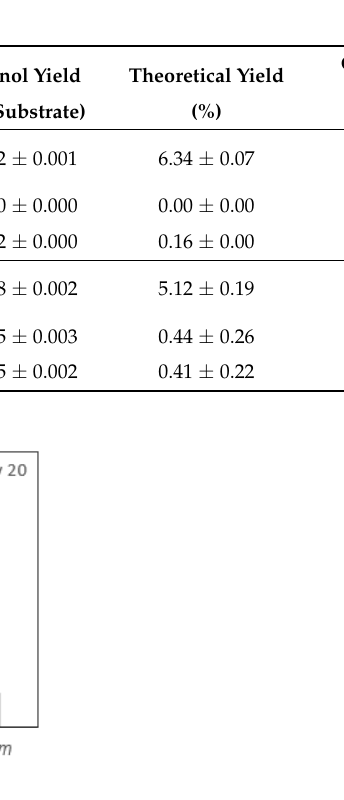
Figure 3. Ethanol production from Napier grass by various fungi after 10 and 20 days.